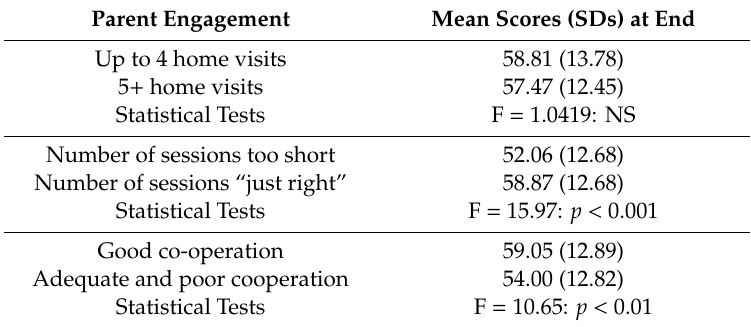
Table 4. The mean and standard deviations (SD) of the wellbeing scores for the subgroupings of parents by their engagement with the project at the start and end of the home visits. ( n =